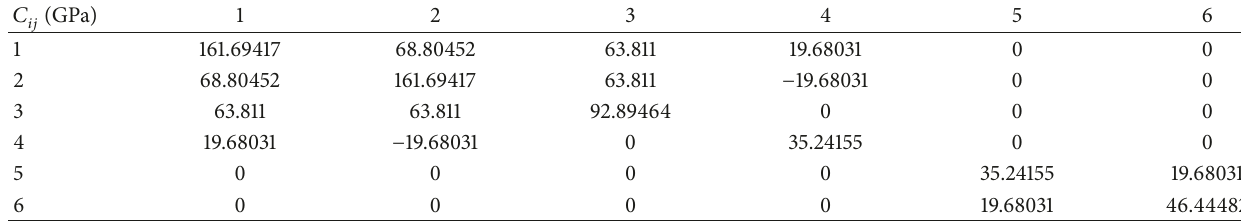
Table 5: Elastic stiffness matrix of calcite crystal.